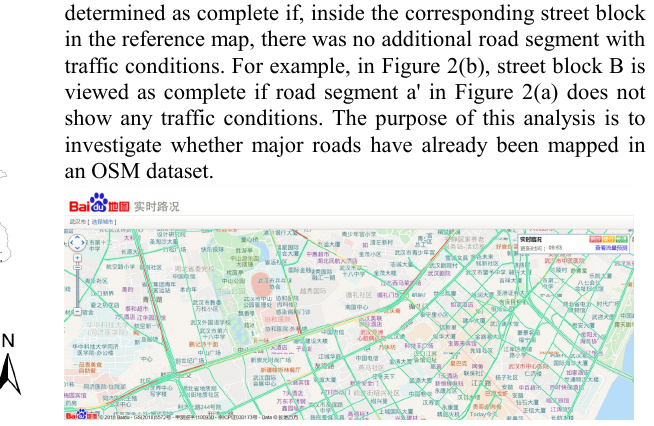
Figure 3. A screenshot of roads with traffic conditions, highlighted with red, yellow, and green, in the Baidu Street Map (©2019